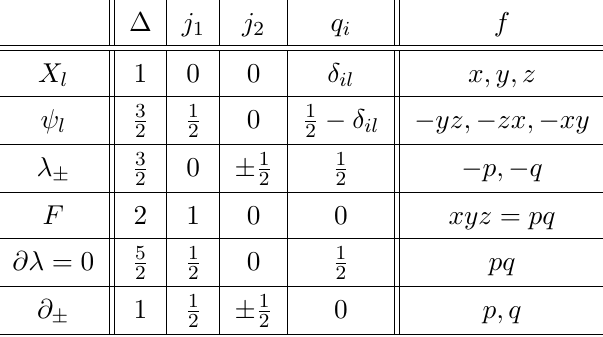
Table 5 . Letters and their charges in the index of N = 4 Yang-Mills. We abbreviated the scalar fields X , Y , Z as X and chiralinos ψ , ψ , ψ as ψ . The fields are charged under angular momenta l X Y Z l U(1) U(1) SO(4) and R-symmetries U(1) 3 ⊂ SO(6) . In the free limit of N = 4 SYM, there is 1 × 2 ⊂ i also a bonus U(1) symmetry Y [55, 89, 90] which assigns 1 to all fields and the supercharge Q and assigns 0 to